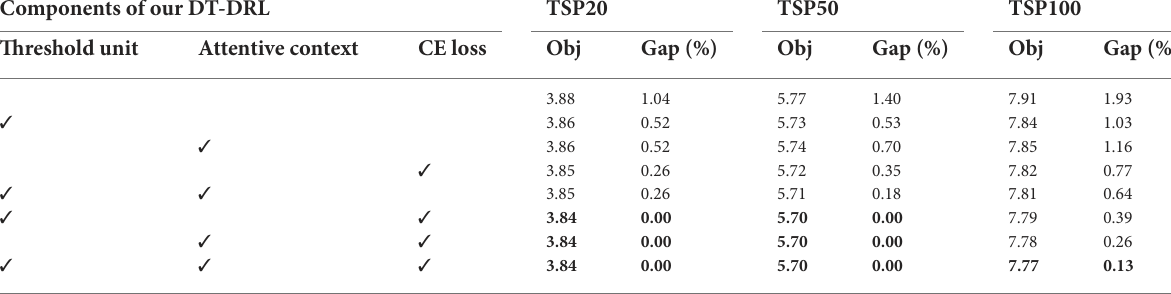
TABLE 3 AblationstudyofdifferentcomponentsofourDT-DRLonTSP. Components of our DT-DRL